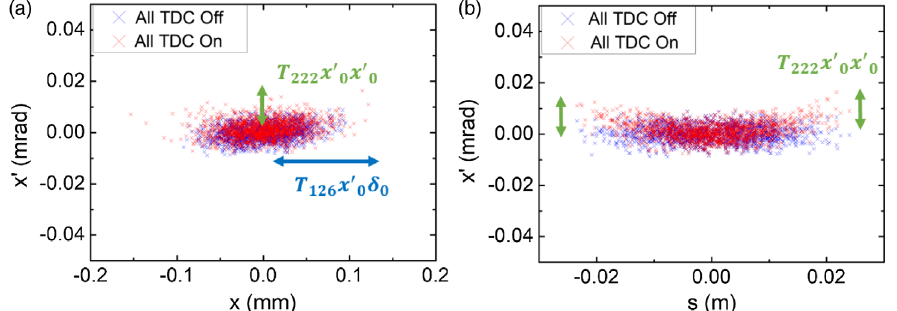
FIG. 8. Particle distributions in the horizontal phase space (a) and horizontal momentum via phase (b) after the second TDC. In this case, the TDC1 voltage is adjusted to get the minimum emittance